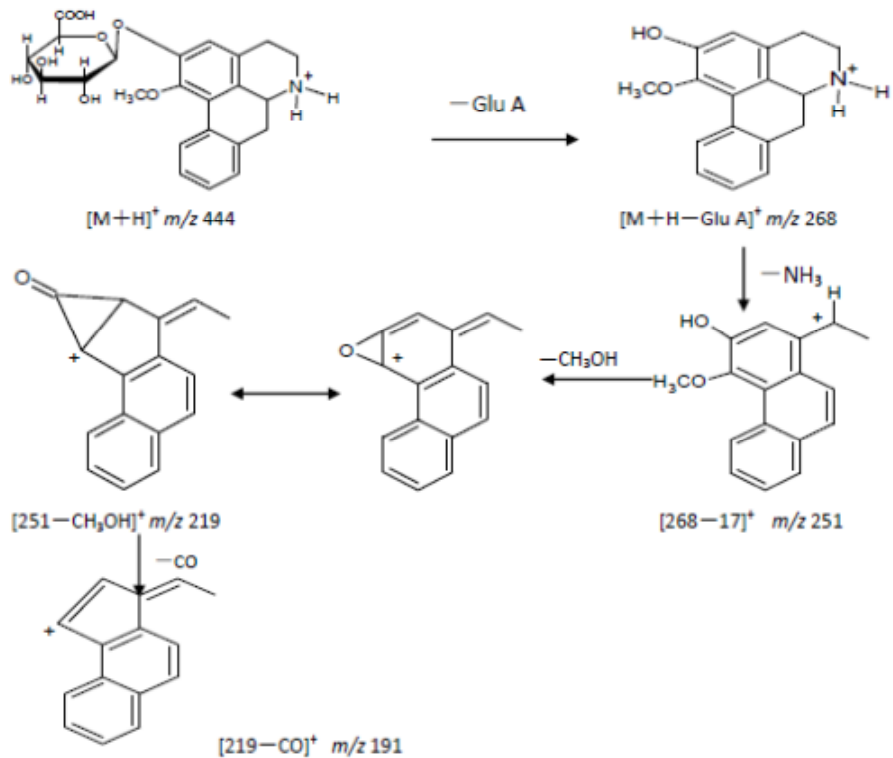
Figure 10. Fragmentation pathway of